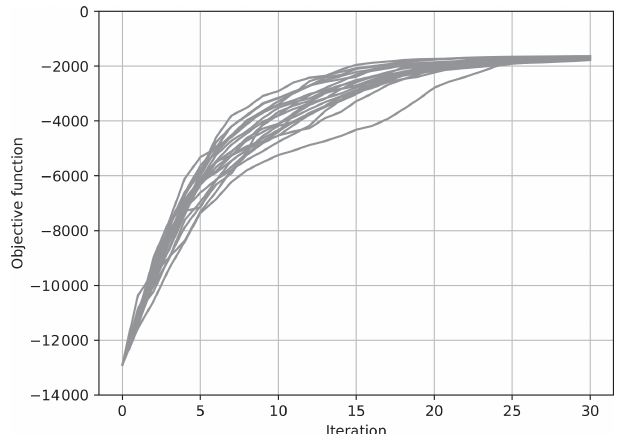
Figure 4. The value of the objective function J for each iteration for 20 trials of the estimation. The ensemble was updated using Eq. (36) with δ = 1 . 5 × 10 − 2 .